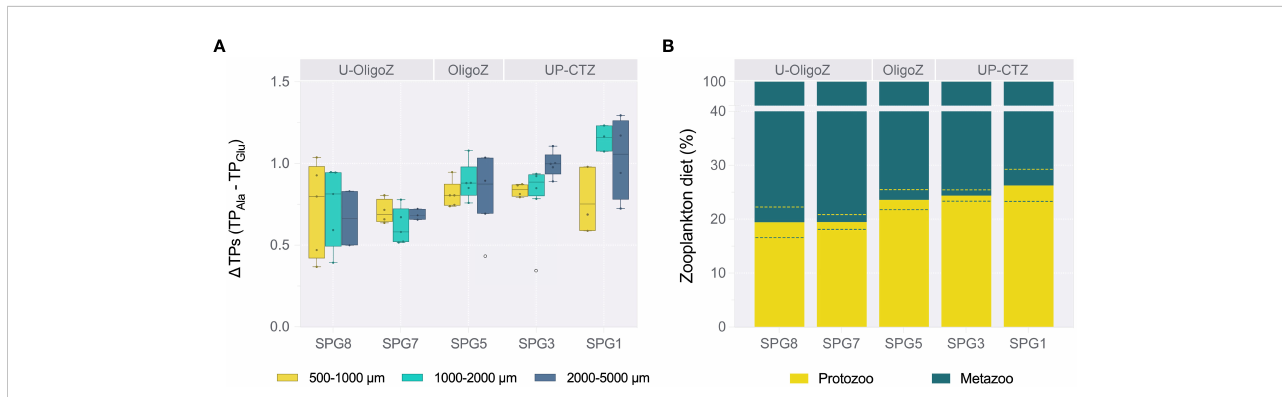
Ala ) or glutamate (TP Glu ) as trophic amino acids. Values were integrated through the water column given that there were no statistical differences in the TPs with depth (Supplementaey Table S6). Each whisker plot represent the 10-90% percentiles, with the upper and lower limits indicating